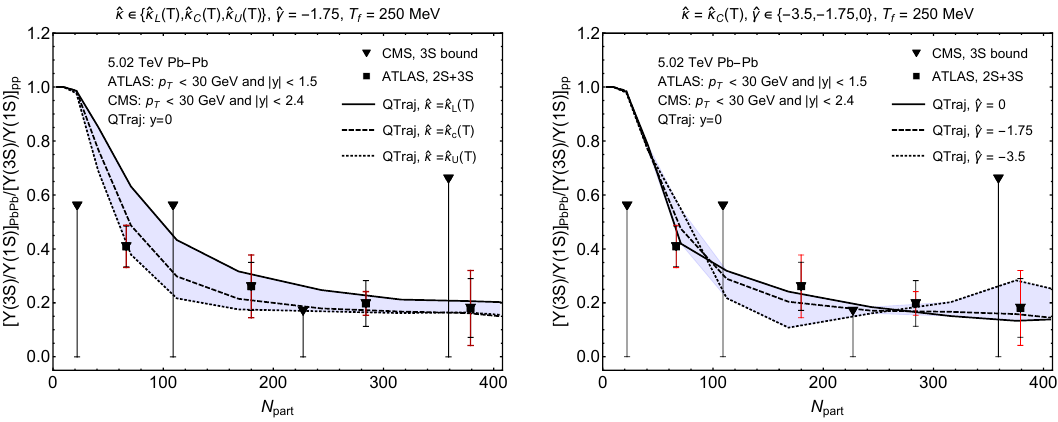
Figure 12 . Double ratio [Υ(3 S ) / Υ(1 S )] PbPb / [Υ(3 S ) / Υ(1 S )] pp as a function of N part . Data and QTraj results are as detailed in the caption of figure 11.